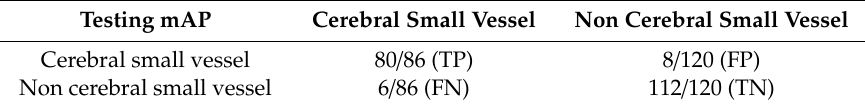
Table 6. Testing mAP of YOLO2 model.